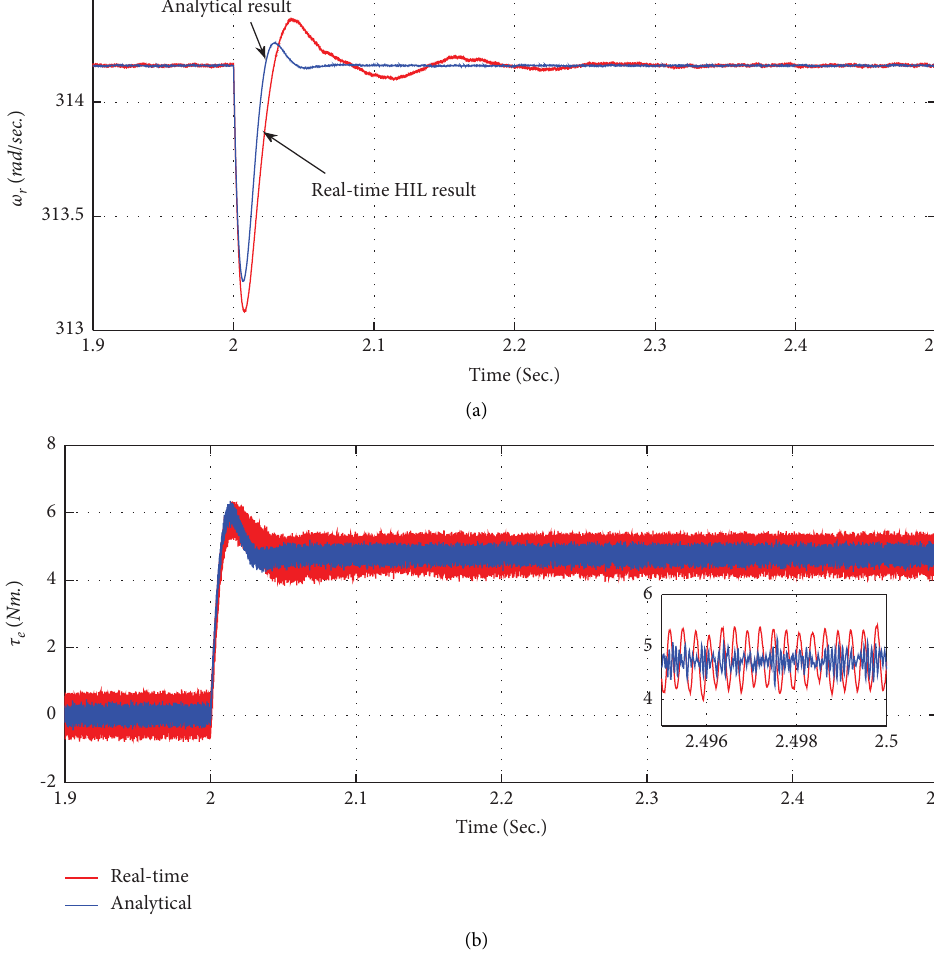
Figure 12: Comparative results of motor showing (a) rotor speed and (b) developed